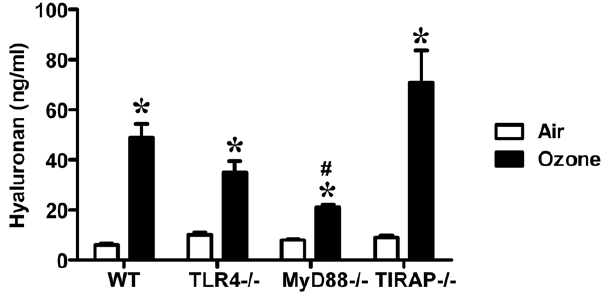
Figure 5. Level of HA in the BALF was increased after exposure to ozone. HA levels were significantly increased in all ozone-exposed groups (*p , 0.01, vs. FA exposed group; # p , 0.05, vs. O3-exposed WT, group, N=4–5 per group).